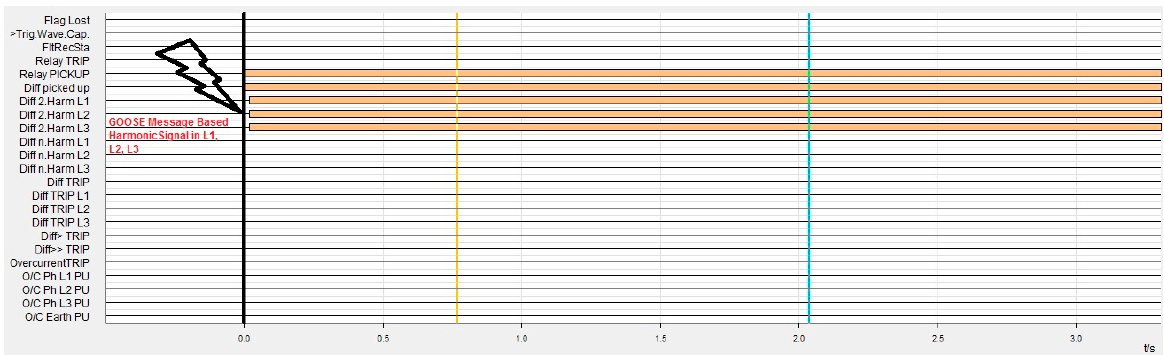
Figure 7. Relay trip during harmonic blocking signal (GOOSE message) recorded by IEDs.